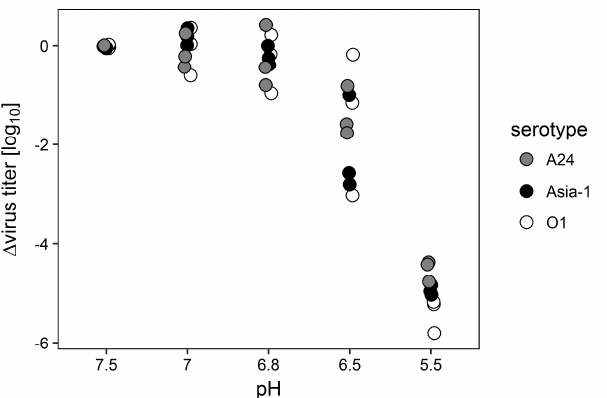
Figure 2. Incubation of FMDV A 24 Cruzeiro, O 1 Manisa and Asia-1 Shamir in PBS solutions of different pH for 30 min. Equal amounts of virus were incubated at pH 7.5, 7.0, 6.8, 6.5 and 5.5 for 30 min. The solutions were neutralized and remaining infectivity was determined by titration. Values on the y-axis represent the reduction in titer compared to virus incubated at pH 7.5. All experiments were independently performed three times.